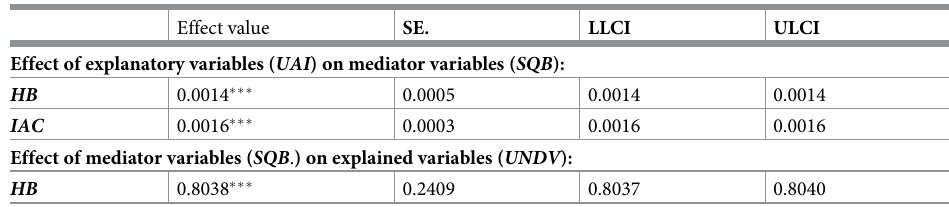
Table 9. The results of bootstrap